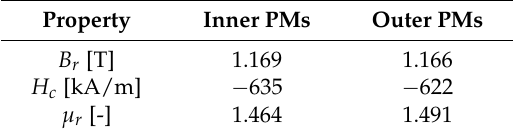
Table 4. Corrected values of inner and outer PM properties as a function of operating